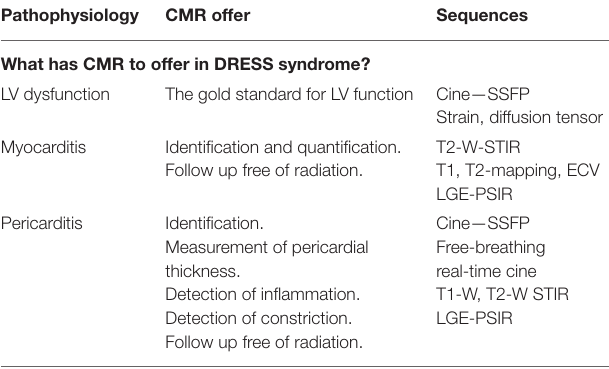
TABLE 9 | CMR offerings to the